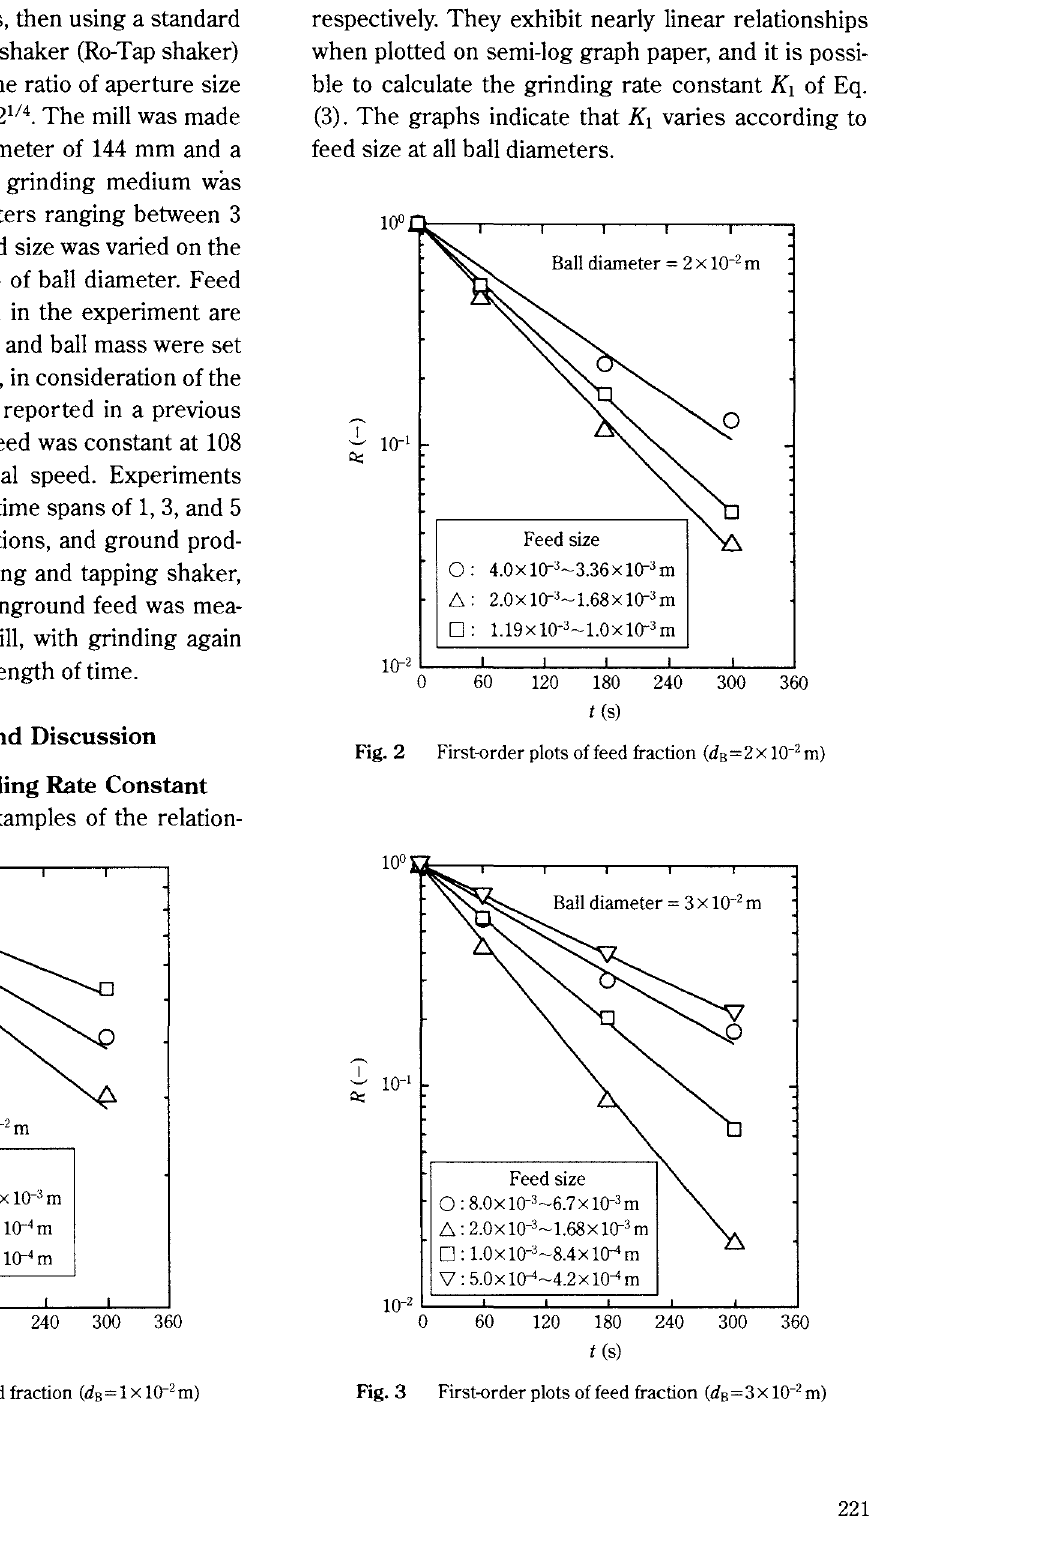
Fig. 3 First-order plots offeed fraction (d 8 =3X 10- 2 m)